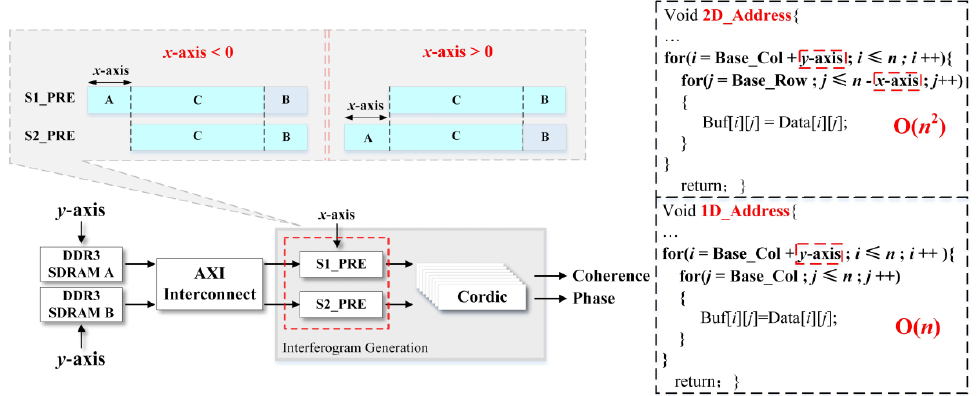
Figure 4. The graduated registration. “Base_Row” represents the initial row address in DDR. “Base_Col” means the initial column address in DDR. Both “Base_Row” and “Base_Col” are base addresses. “ y -axis” and “ x -axis” denote the offset addresses.